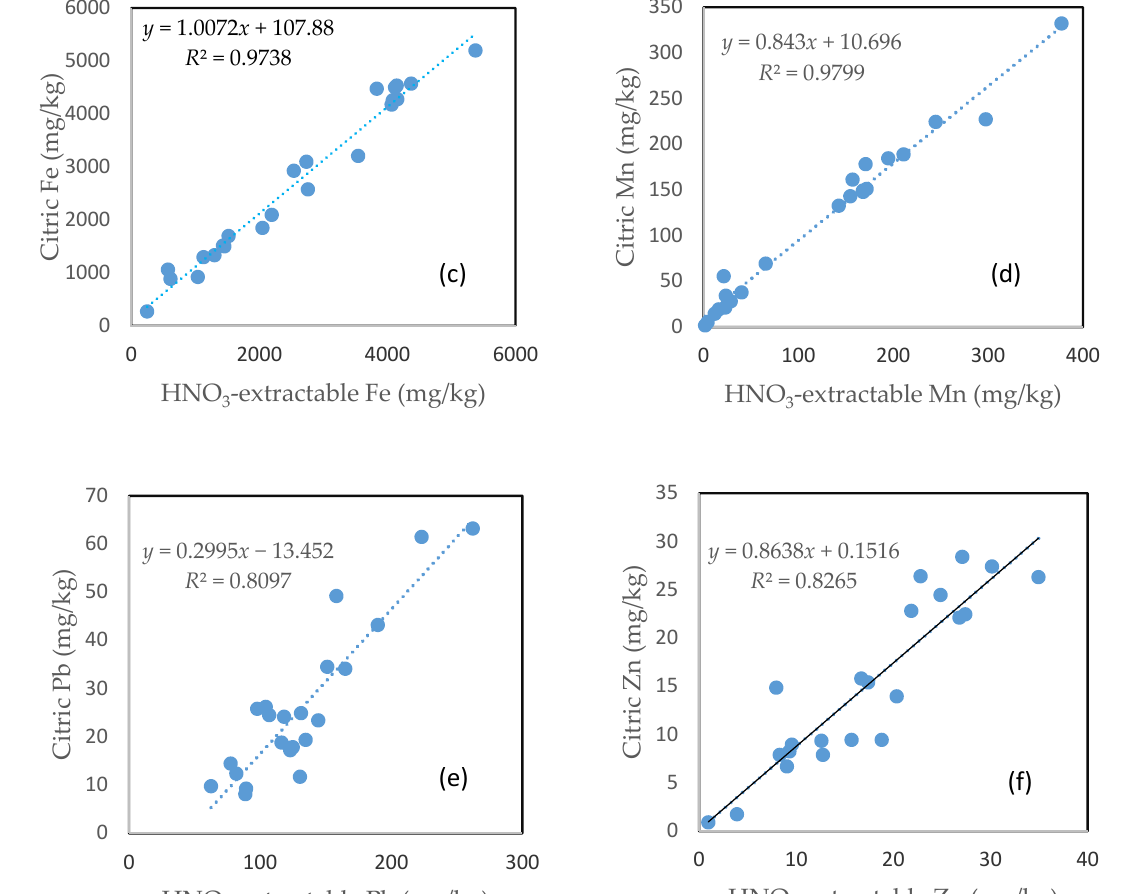
Figure 7. Relationship between the HNO 3 -extractable fraction and the citric acid-extractable fraction for ( a ) As, ( b ) Cu, ( c ) Fe, ( d ) Mn, ( e ) Pb, and ( f ) Zn.